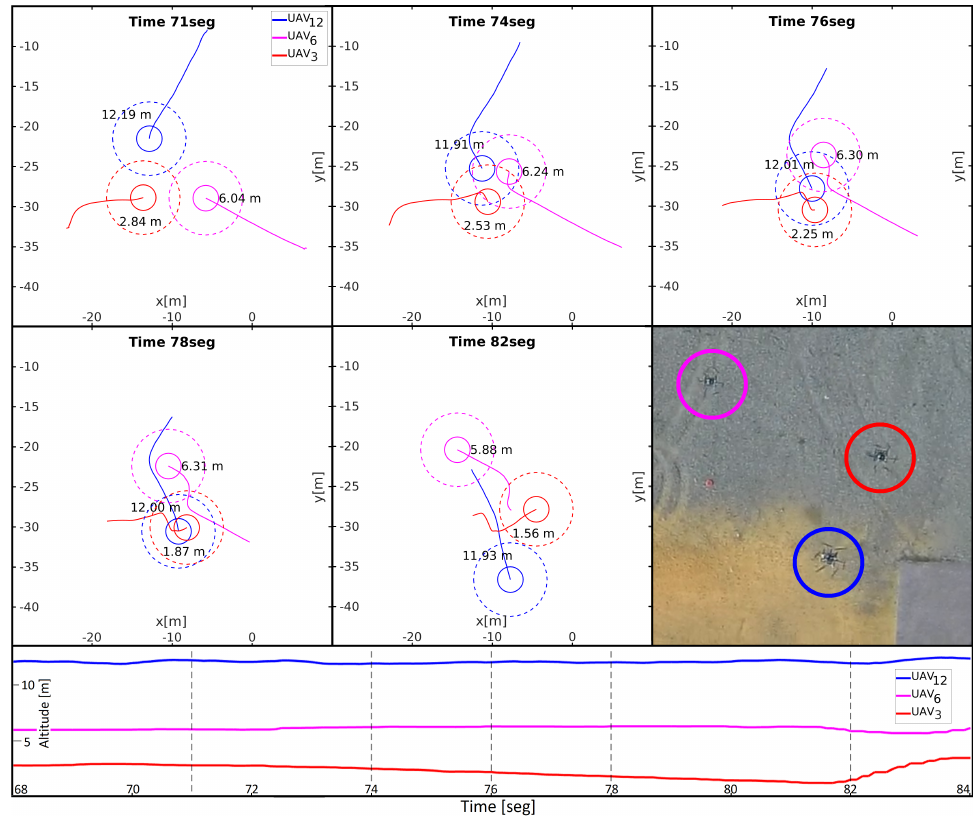
Figure 9. Different snapshots with the paths followed by the 3 UAVs during a field experiment. The last snapshot is the final view of the actual experiment. Solid circles represent collision cylinders and dashed circles reserved cylinders. Each UAV is labeled with its altitude. At the bottom, the evolution of the altitudes of the UAVs along the experiment are shown, together with marks on the time instants when the above snapshots were